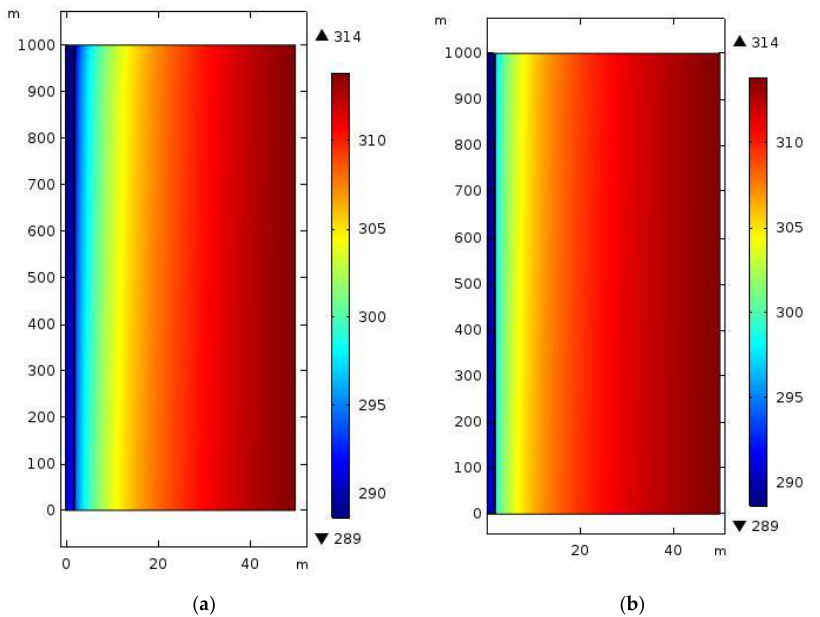
Figure 7. Comparison of the effects of thermal insulation of support materials (transverse section): ( a ) Nephogram of the temperature field of the roadway supported by using common sprayed concrete; ( b ) Nephogram of the temperature field of the roadway supported by using the new heat-insulating materials with basalt fibres.